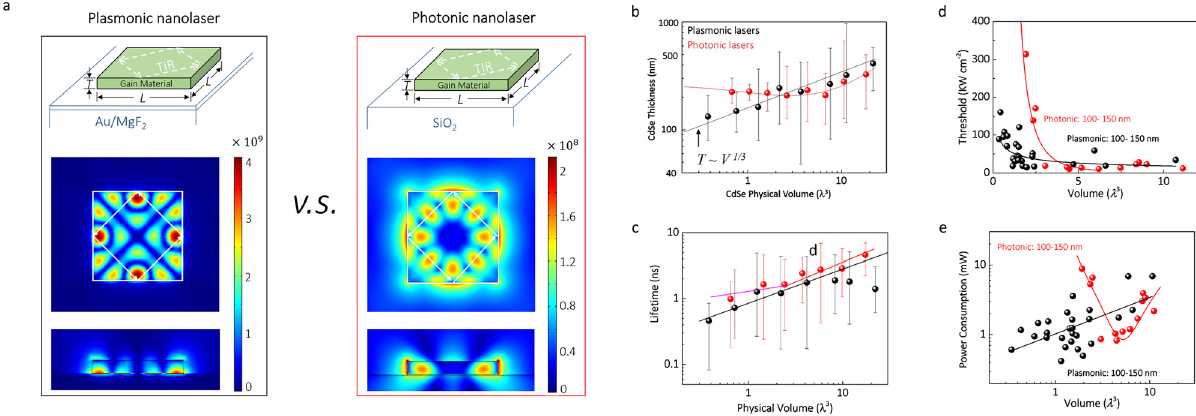
Figure 2: Scaling laws of plasmonic and photonic nanolasers. a In total, 170 plasmonic nanolasers (left) and photonic nanolasers (right) were measured for performance comparison. b – e Comparisons of cavity size (b), spontaneous emission lifetime (c), threshold (d), and power consumption (e). These comparisons suggest that plasmonic nanolasers can be more compact and faster with lower power consumption than photonic nanolasers when the cavity size approaches or surpasses the diffraction limit. Figure adapted